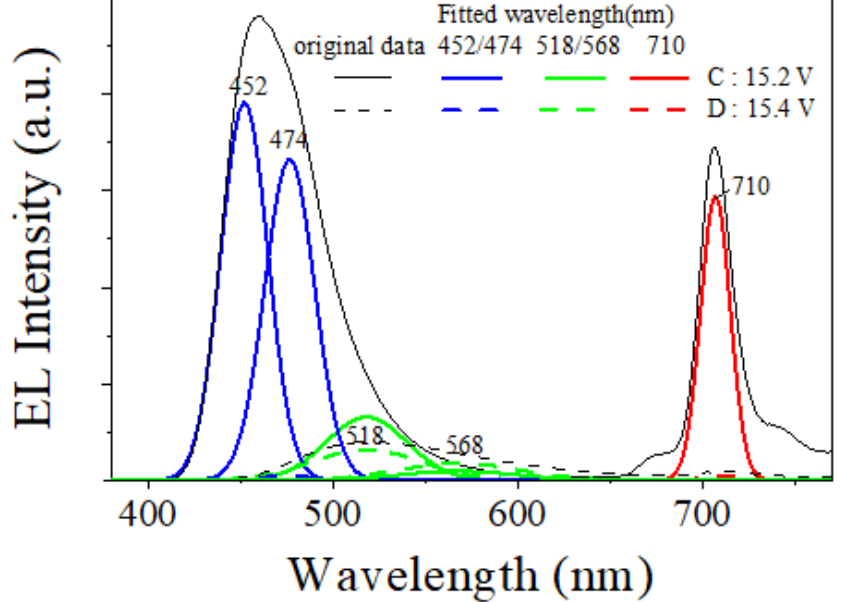
Figure 8. Multi-peak fit of the CTOLED after thermal treatment using a Gaussian function at an applied voltage of 15.2 and 15.4 V. At the applied voltage of 15.4 V, original and multi-peak fitted data of ELs are shown to be amplified 10 times.